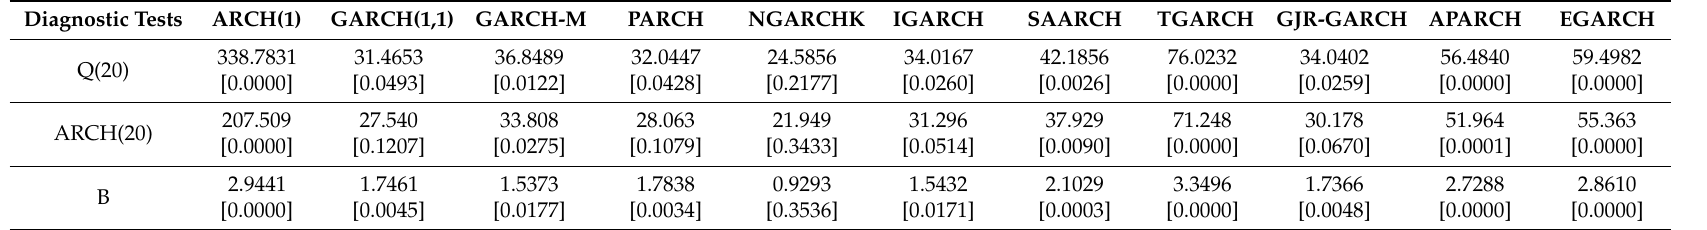
Table A2. Models’ diagnostic tests for electricity prices, Ljung–Box Q, ARCH, and Bartlett test results are reported.